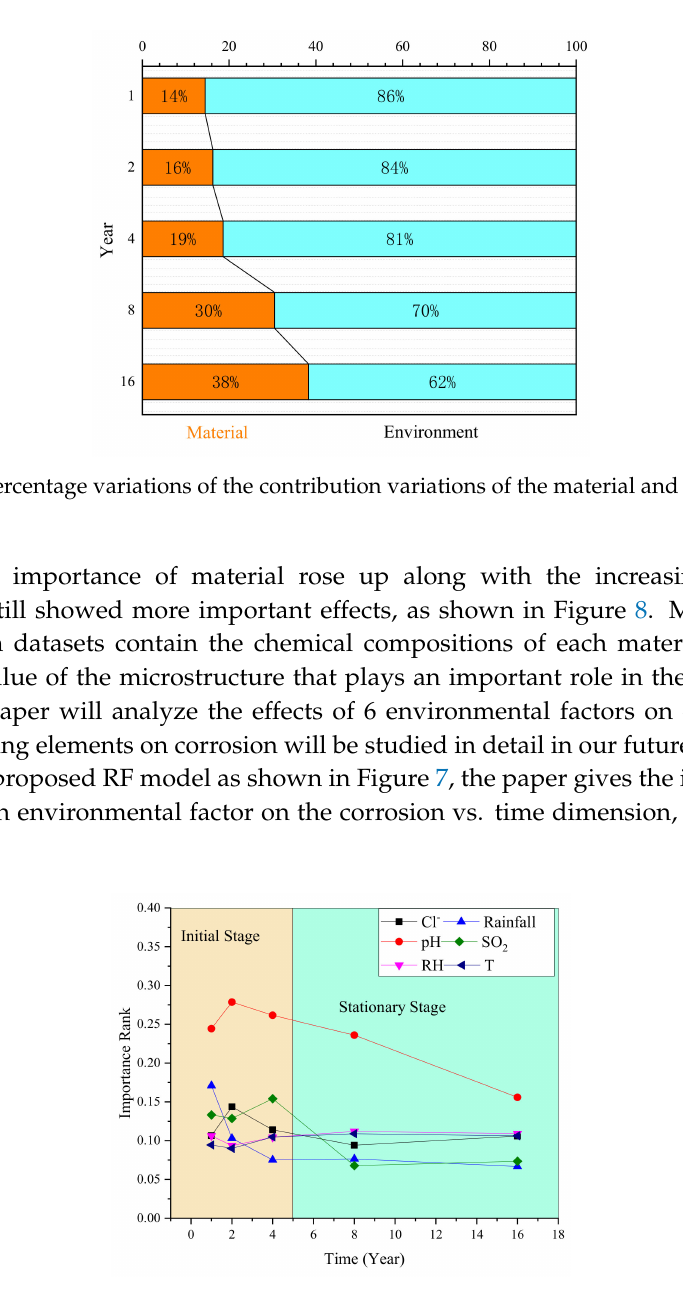
Figure 9. The importance changes of the six environmental factors vs. exposure